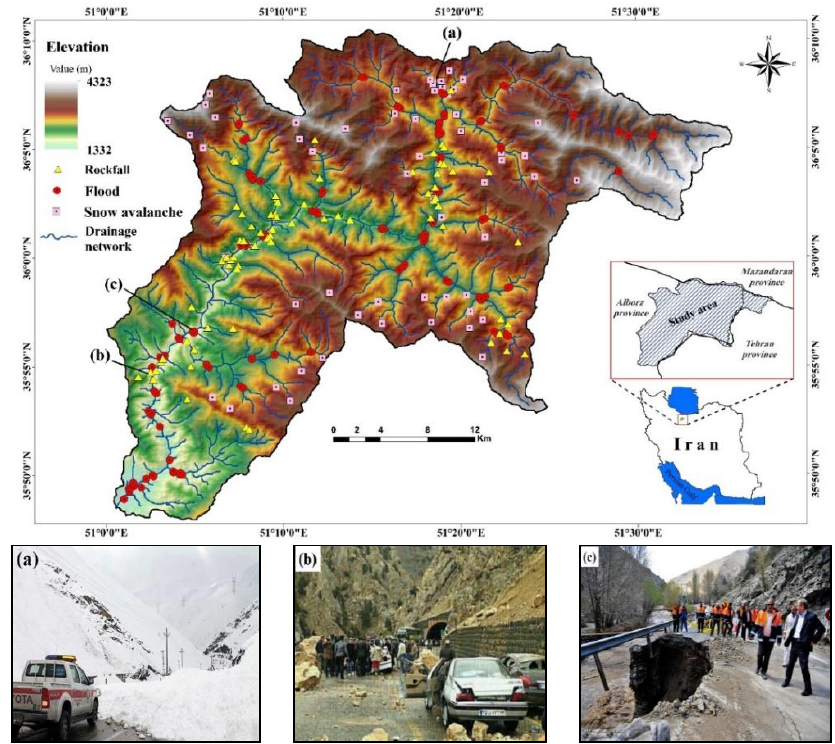
Figure 1. Geographical position of study area and different natural hazard occurrences including flood, snow-avalanche, and rockfall. Field photographs of some natural hazard events occurred in the study area: ( a ) Snow-avalanche between Kandovan Tunnel and Gachsar, ( b ) rockfall in the South of Vineh village, and ( c ) flood in the north of Vineh village.